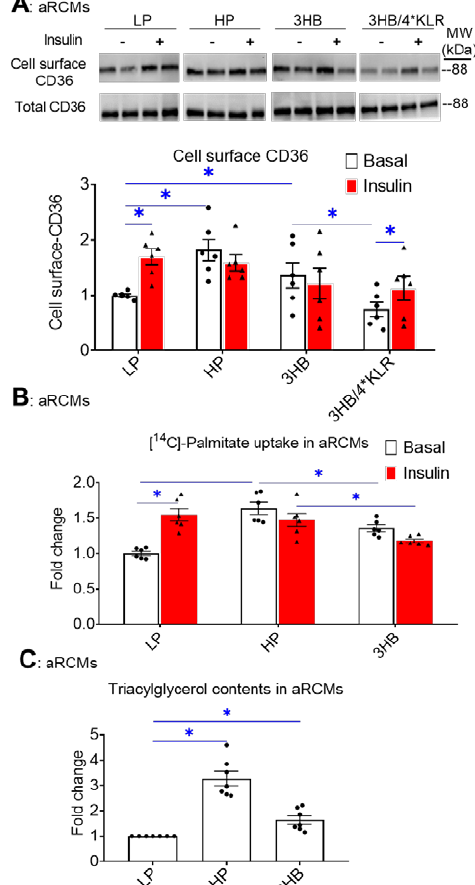
Figure 2. Chronic 3HB exposure induces CD36-mediated lipid accumulation in cardiomyocytes. ARCMs were cultured for 24 h in either low palmitate medium (LP; control condition), high palmitate medium (HP), LP with 3 mM 3HB (3HB), or LP with 3HB in the presence of 4*KLR (3HB/4*KLR). ( A,B ) After 24 h, cells were short-term (30 min) incubated without/with 100 nM insulin. ( A ) Assessment of cell-surface CD36 using biotinylation assay. For this, CD36 was detected by Western blotting in biotin immunoprecipitations and total cell lysates and subsequently quantified (n = 6). ( B ) [14C]palmitate uptake (n = 6). ( C ) Triacylglycerol contents (n = 7). Bar values are means ± SEM. * p < 0.05. The dots represent the measurements that are performed under ‘basal’ condition. The triangles represent the measurements that are performed after insulin